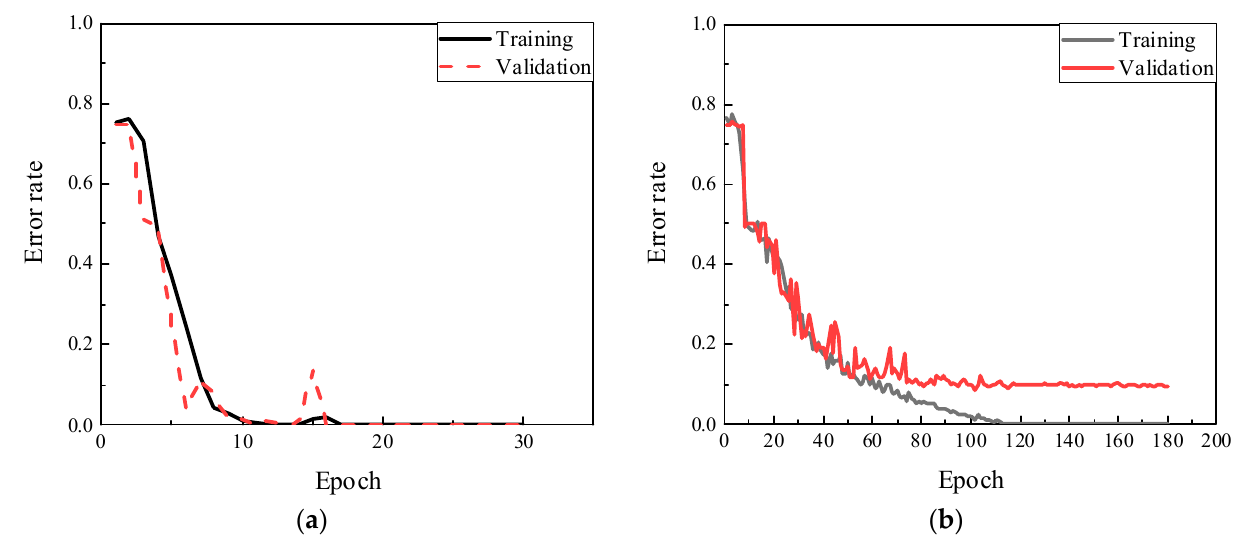
Figure 25. Training and validation results. ( a ) SNR = 80 dB ( b ) SNR = 70 dB.